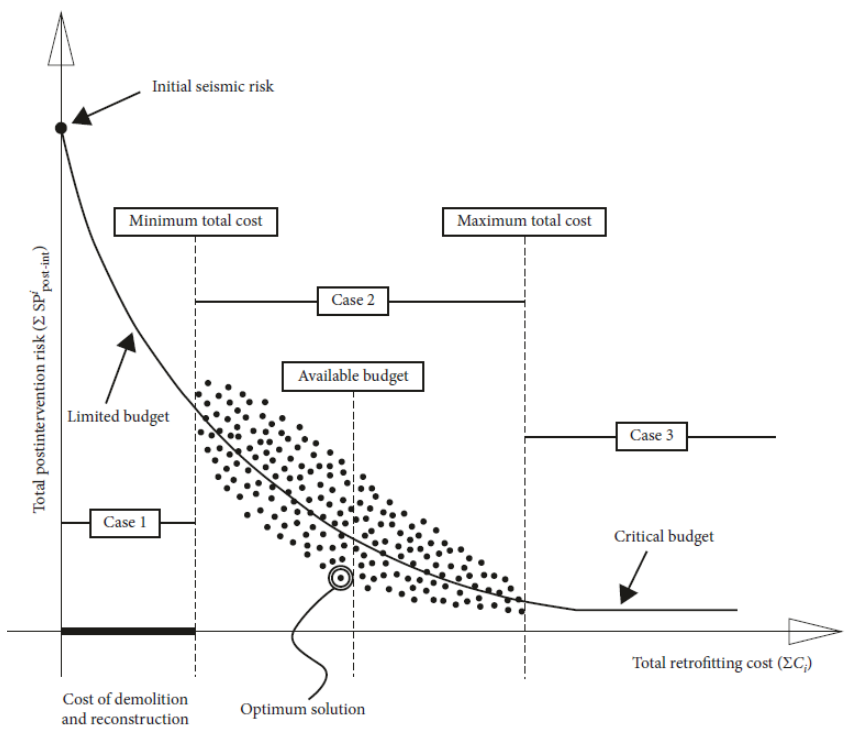
Figure 3. Total retrofitting cost versus total post-intervention seismic risk [19].